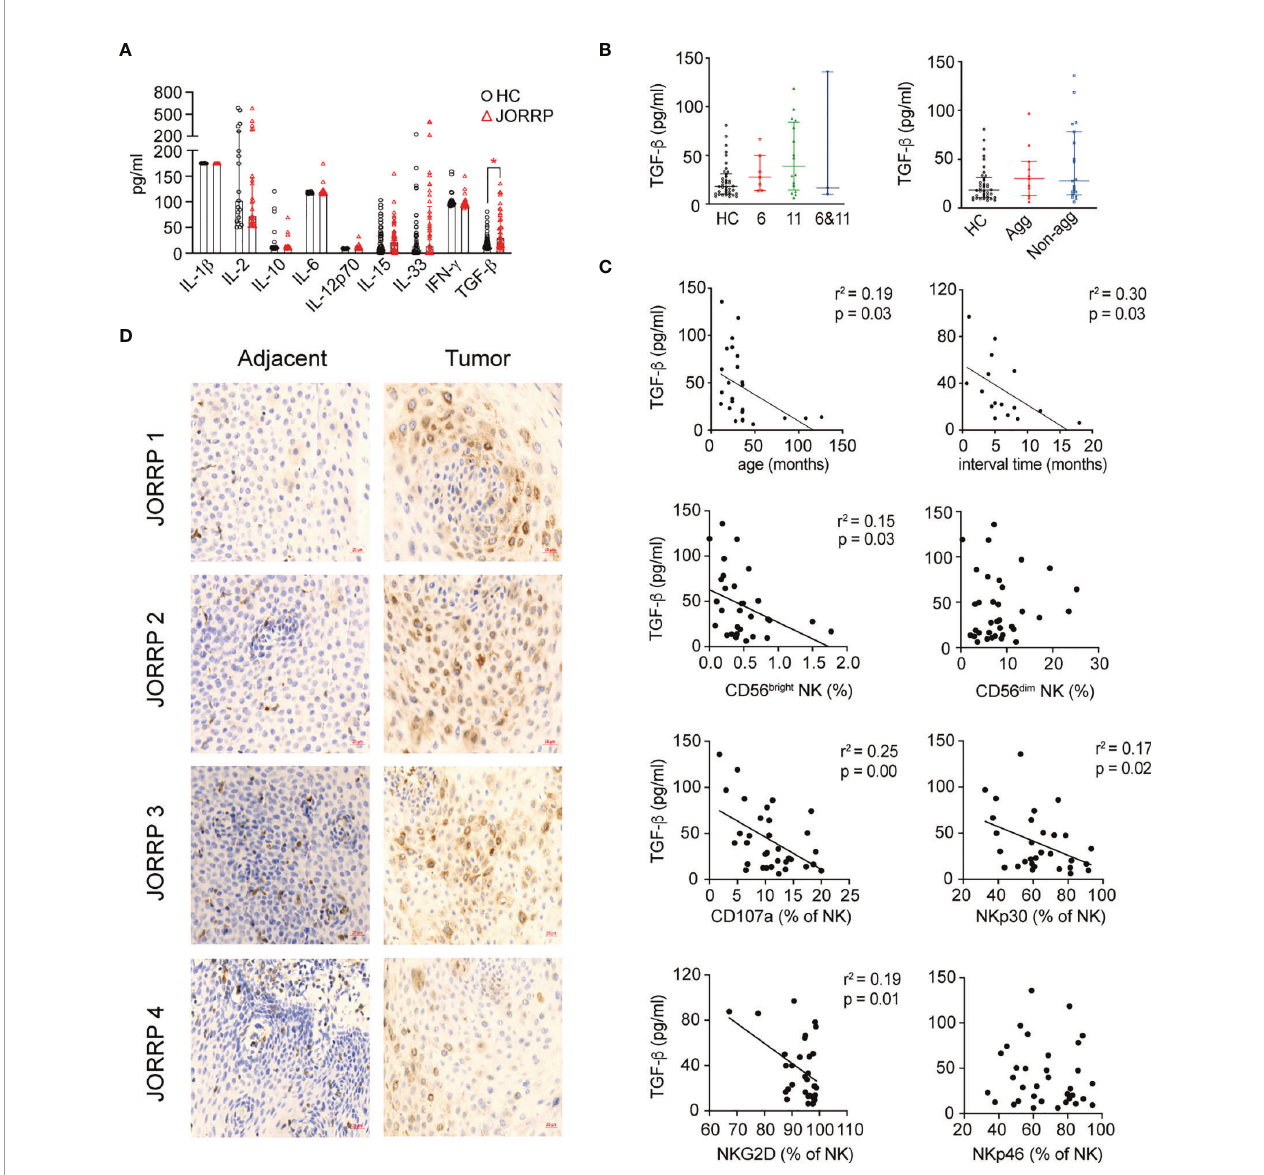
FIGURE 4 | Higher Transforming Growth Factor (TGF)- b level in plasma and papillomatosis of JORRP patients and associated with decreased NK cell cytotoxicity. (A) Measurement of multiple cytokine concentrations in plasma of HCs and JORRP patients by CBA (IL-1 a , IL-2, IL-10, IL-6, IL-12p70, IL-15, IL-33, IFN- g ) and TGF- b 1 by ELISA. (B) Immunohistochemistry of TGF- b 1 in tumor sections (right) and paired adjacent nontumor sections (n = 4). Bar: 20 m m. (C) Concentration analysis of TGF- b 1 in different subgroups of JORRP patients. Agg, aggressive (n = 11); Non-agg, non-aggressive (n = 19); 6, HPV6 (n = 7); 11, HPV11 (n = 16); 6&11, HPV6&HPV11 (n = 3). (D) Correlation of plasma TGF- b 1 with age of fi rst occurrence, interval time, the percentage of CD56 bright and CD56 dim NK, CD107a, NKp30, NKp46, NKG2D, and NKp44 expression on NK cells. Spearman ’ s correlation coef fi cients are shown. Data are presented as mean ± SD. Each dot represents a single patient. *P <